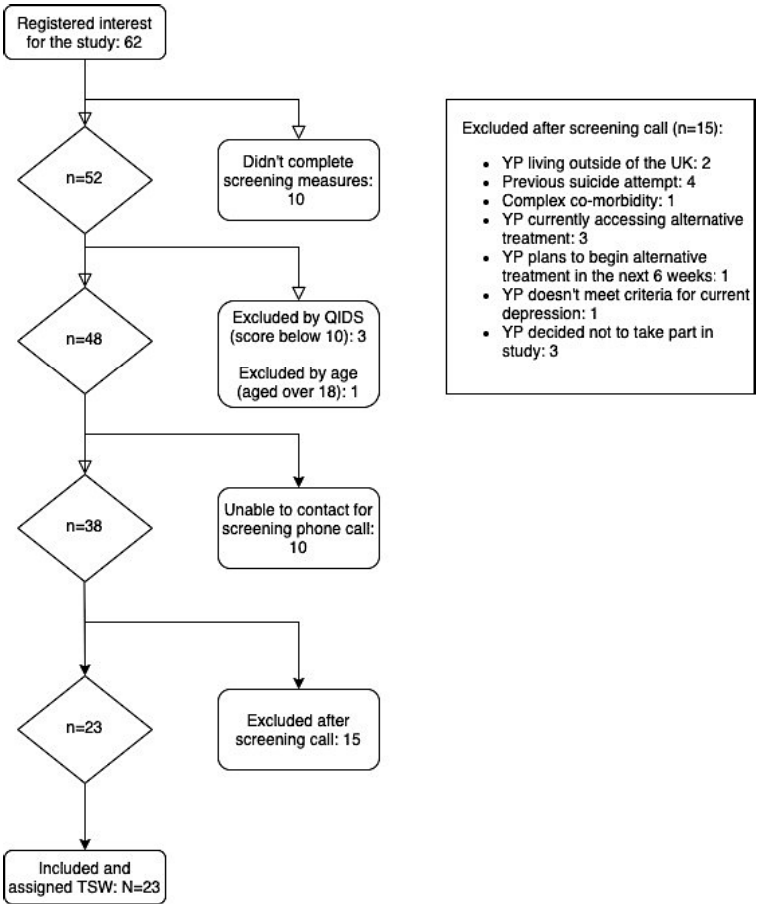
Figure 1. CONSORT diagram. Note. YP = young person. QIDS = Quick Inventory of Depressive Symptomatology. TSW = therapeutic support worker. Table 1. Participant Demographic